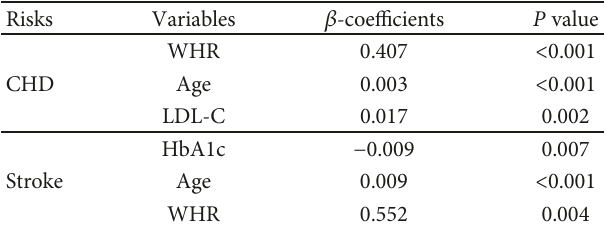
Table 4: Regression analysis on CHD or stroke risk (18 months) and basal clinical metabolic variables in patients with diabetes and obesity ( n = 20